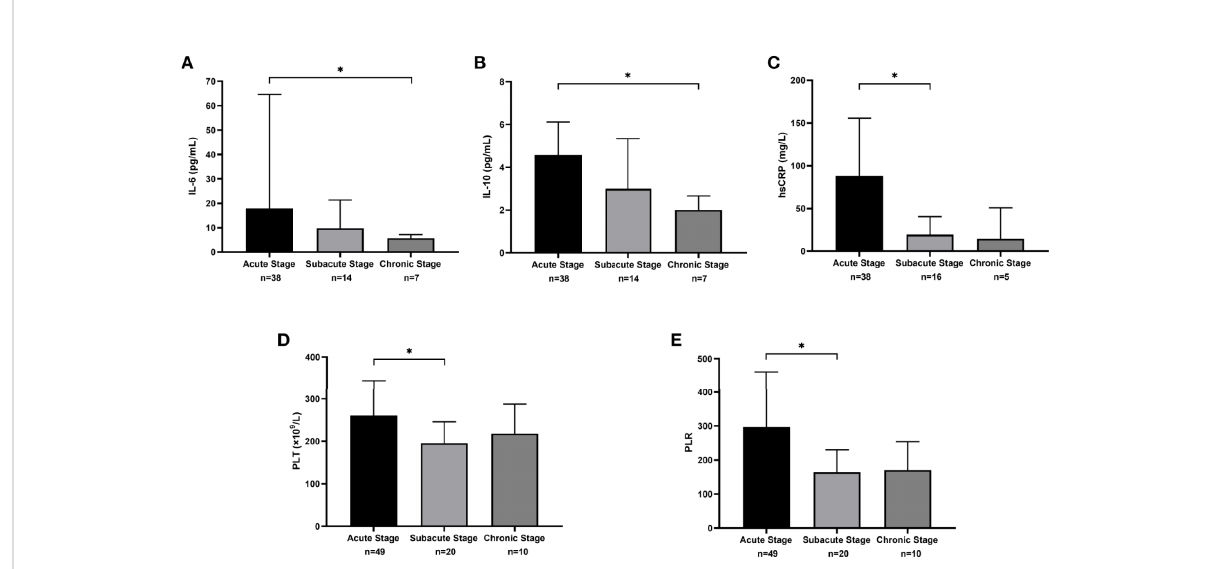
FIGURE 5 The median and interquartile range of laboratory measures that were statistically different across clinical phases. (A) The results of interleukin (IL)-6 (pg/mL). (B) The results of IL-10 (pg/mL). (C) The results of sensitivity C-reactive protein (hsCRP) (mg/L). (D) The results of platelet count (PLT) (×10 9 /L). (E) The results of platelet-to-lymphocyte ratio